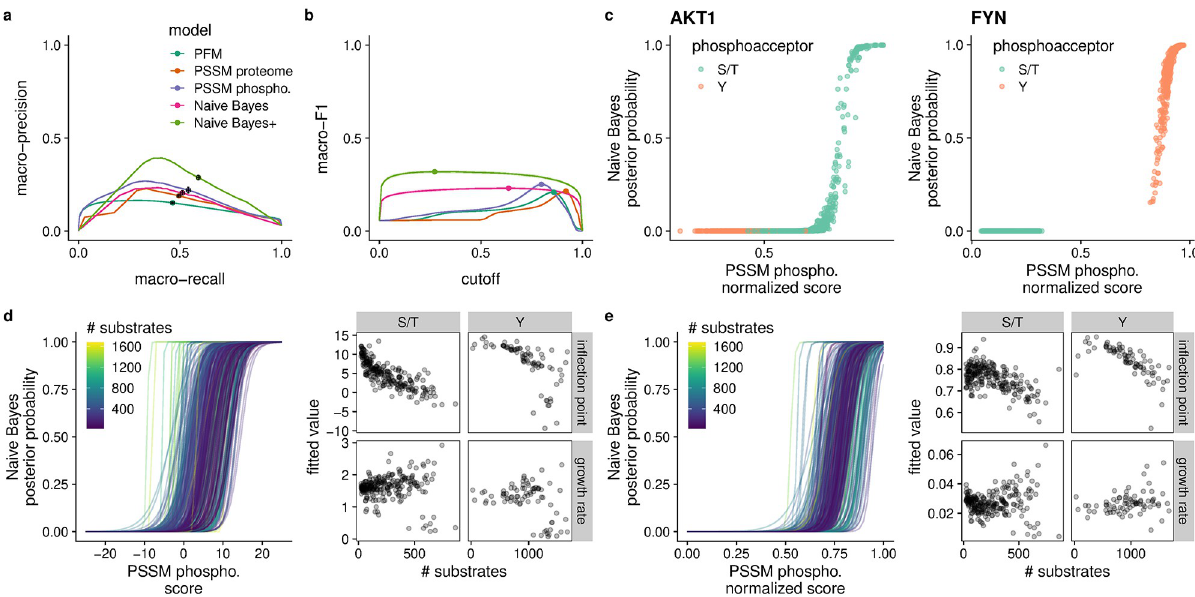
Fig 2. Na ï ve Bayes models of in vitro kinase-phosphosite assignment have important performance differences from PSSM-based methods. a) PSSM methods and Na ï ve Bayes perform similarly in cross-validation of multi-label kinase-substrate assignment via macro-averaged precision versus recall. The expanded Na ï ve Bayes+ model outperforms the other methods. Points indicate the scores at the cutoff that maximizes that macro-F1 score. Black error bars showing 95% confidence intervals at these points are indiscernible in most cases, indicating highly robust performance across cross- validation folds. b) The macro-averaged F1 scores behave differently with score/probability cutoff for scoring matrix-based models versus Na ï ve Bayes. PSSM and PFM-based models require a strictly defined cutoff. Na ï ve Bayes+ again outperforms the others and retains the same flat relationship with cutoff as basic Na ï ve Bayes. Points indicate the maximum value. Bands indicate the 95% confidence interval. Color assignments are the same as in (a). c) Example score distributions for a S/T kinase (AKT1) and a Y kinase (FYN) from one round of cross-validation. For S/T kinases, Na ï ve Bayes probabilities are largely distributed close to 0.0 and 1.0 while PSSM scores take more intermediate values, notably including scores for Y sites. Y kinases show better separation for both methods. d) Left: Logistic curves relating phosphoproteome-backed PSSM scores to Na ï ve Bayes probabilities. Each curve represents a fitted logistic function for each kinase. The color of the curve represents the number of kinase substrates used to fit each specificity model. Right: The fitted logistic curve parameters versus number of substrates. S/T and Y kinases have negative relationships between inflection point and numbers of substrates. e) Min-max normalization of PSSM scores does not produce a stable inflection point independent of the number of